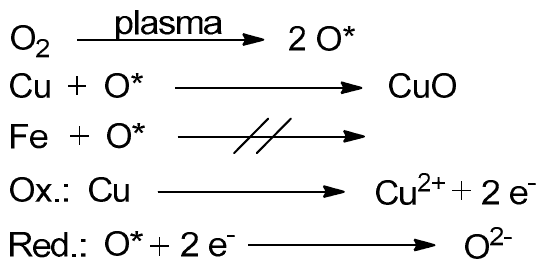
Figure 3. Redox equations of metal oxidation based on the experimental results. The first equation describes a plasma-induced dissociation of molecular oxygen to excited oxygen atoms (O*). The two equations below show the specific oxidation and reduction processes.